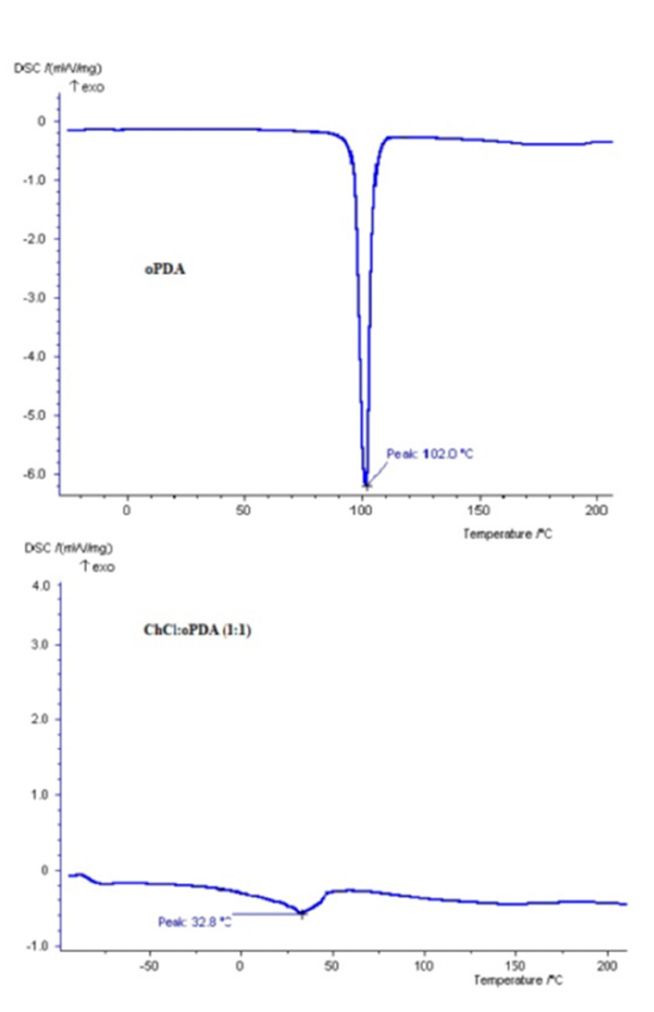
Figure 3. Eutectic temperature (T f ) of ChCl with o -phenylendiamine ( o -PDA). The melting point of pure ChCl is 302 °C.